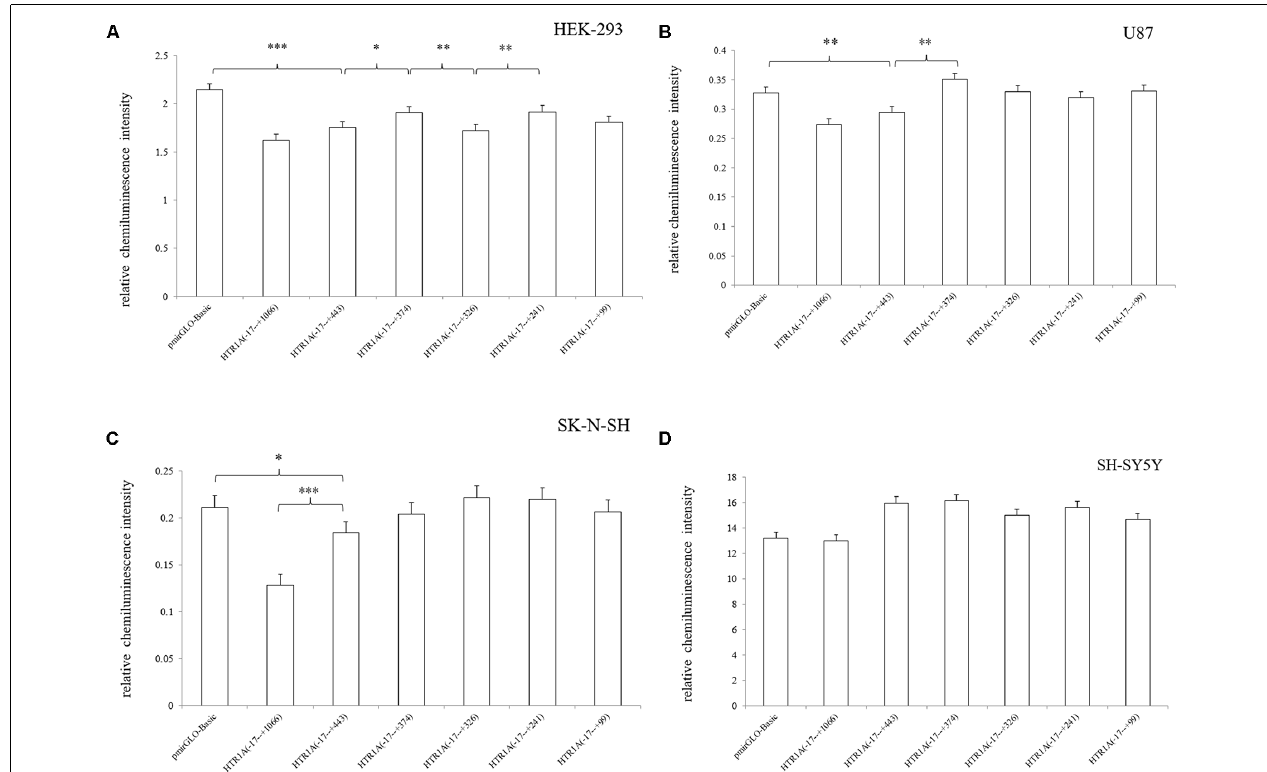
FIGURE 2 | Relative chemiluminescence intensities of the functional sequences of the HTR1A gene 3 (cid:48) -UTR region (A–D) . In HEK-293, U87 and SK-N-SH cell lines, the relative chemiluminescence intensity of the 3 (cid:48) -UTR complete sequence ranging from − 17 bp to +443 bp was significantly decreased. The sequence +375 bp to +443 bp also showed the strongest inhibitory effect on protein expression in HEK-293 and U87 cells. Relative chemiluminescence intensity of each sample is expressed as the mean ± SD, and the LSD-T test was used to compare the two samples. ∗ 0.02 ≤ p < 0.05, ∗∗ 0.001 ≤ p < 0.02, ∗∗∗ p <